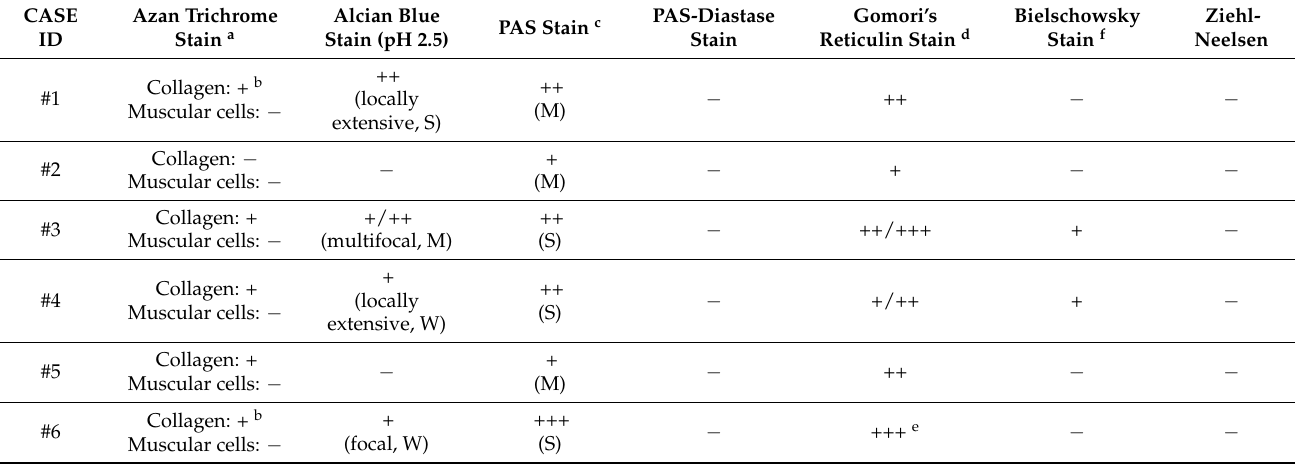
Table 1. Overview of the histochemical findings in dermal atypical neurofibroma from six